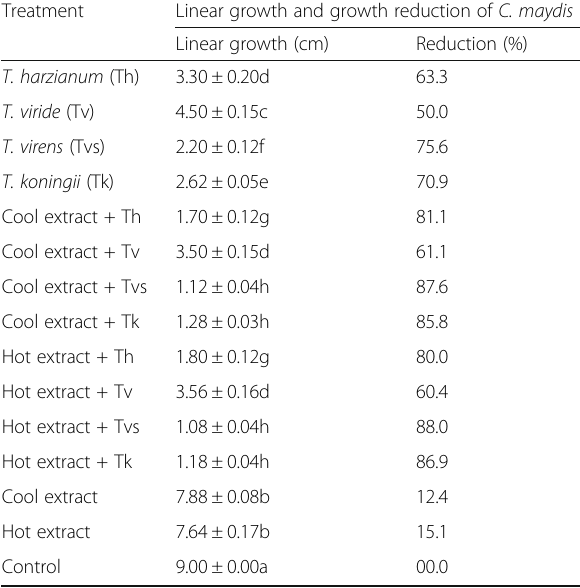
Table 3 Antagonistic activity of Trichoderma spp. alone or